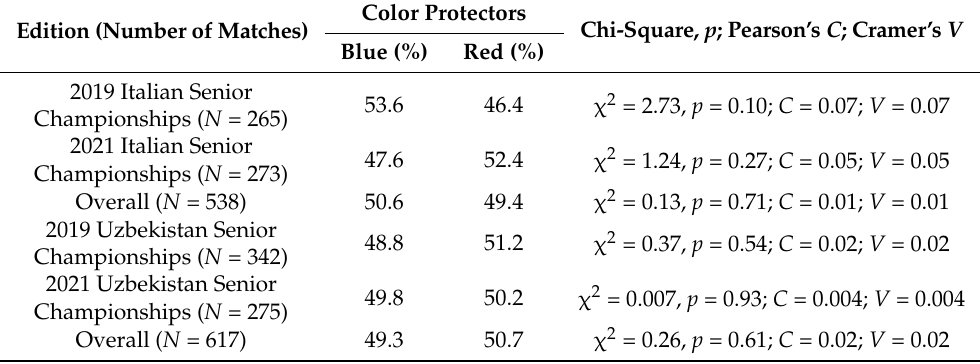
Table 2. Percentage of winners wearing blue and red protectors in each National Senior Taekwondo